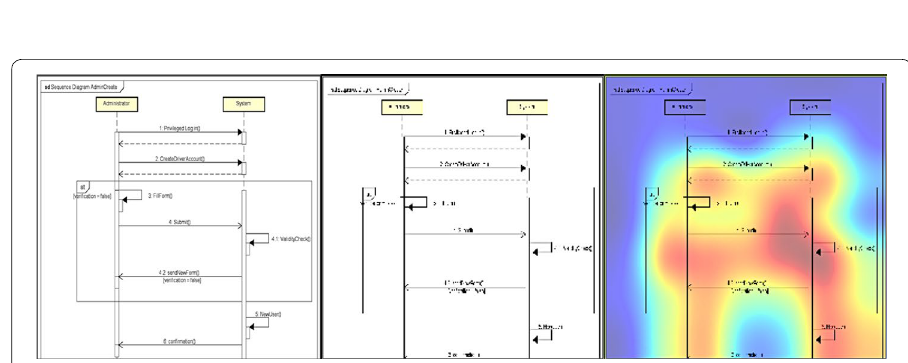
Fig. 5 Class activation mapping prediction for a selected UML sequence diagram, original image on the left, resized image in the middle, heatmap indicating significant features on the